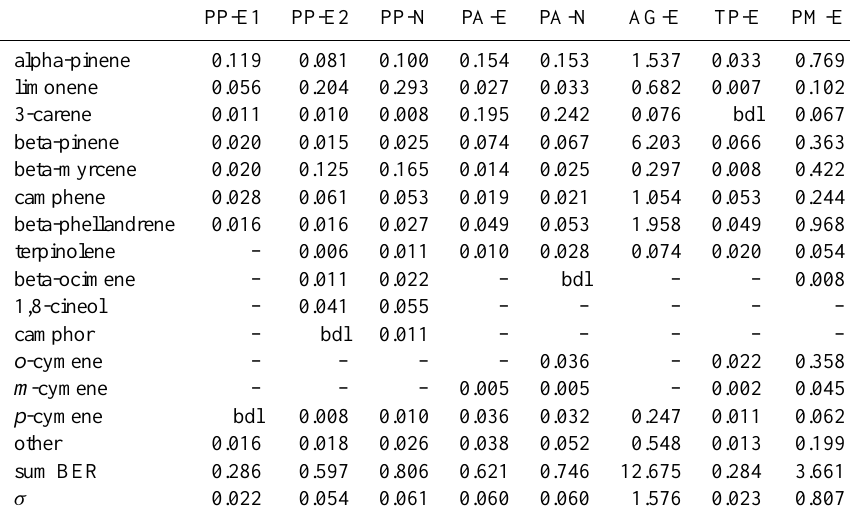
Table 4. Summary of the temperature-normalized pre-treatment emission rates for the dominant compound emissions. Units are emission rates in µg-Cg − 1 h − 1 normalized to 303K. A dash indicates the compound was not detected and bdl indicates the compound was detected but it was below the calculated detection limit for quantification (detection limit = 0.003µg-Cg − 1 h − 1 ). The average sum basal emission rate (BER) is provided at the bottom of the table for each experiment; σ denotes the standard deviation of the measurements used to calculate the pre-treatment